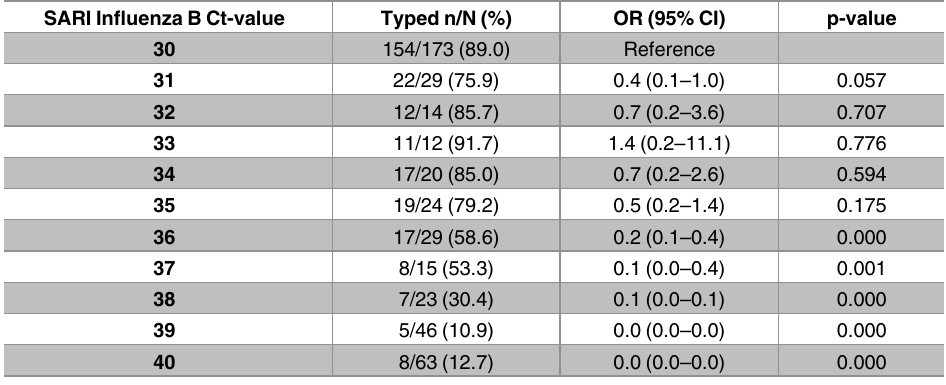
Table 3. Proportion of typed samples by influenza B Ct-value among patients with